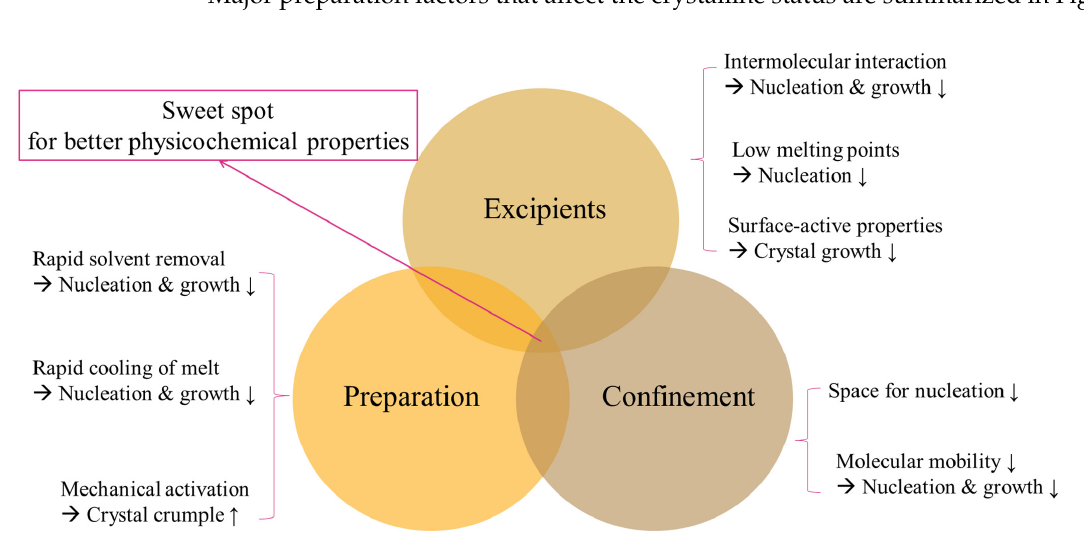
8 of 27 Figure 5. DSC thermograms of β -carotene, a β -carotene-PLGA-PVP physical mixture, and β -caro-